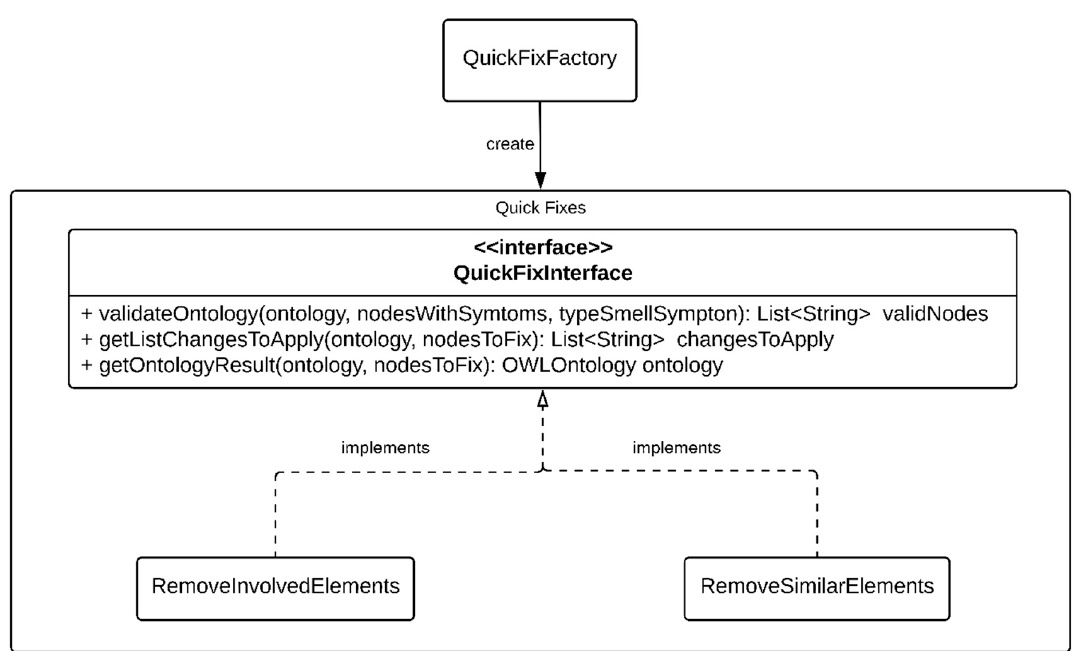
Figure 7. QuickFix Figure 7. QuickFix interface. Figure 7. QuickFix interface.